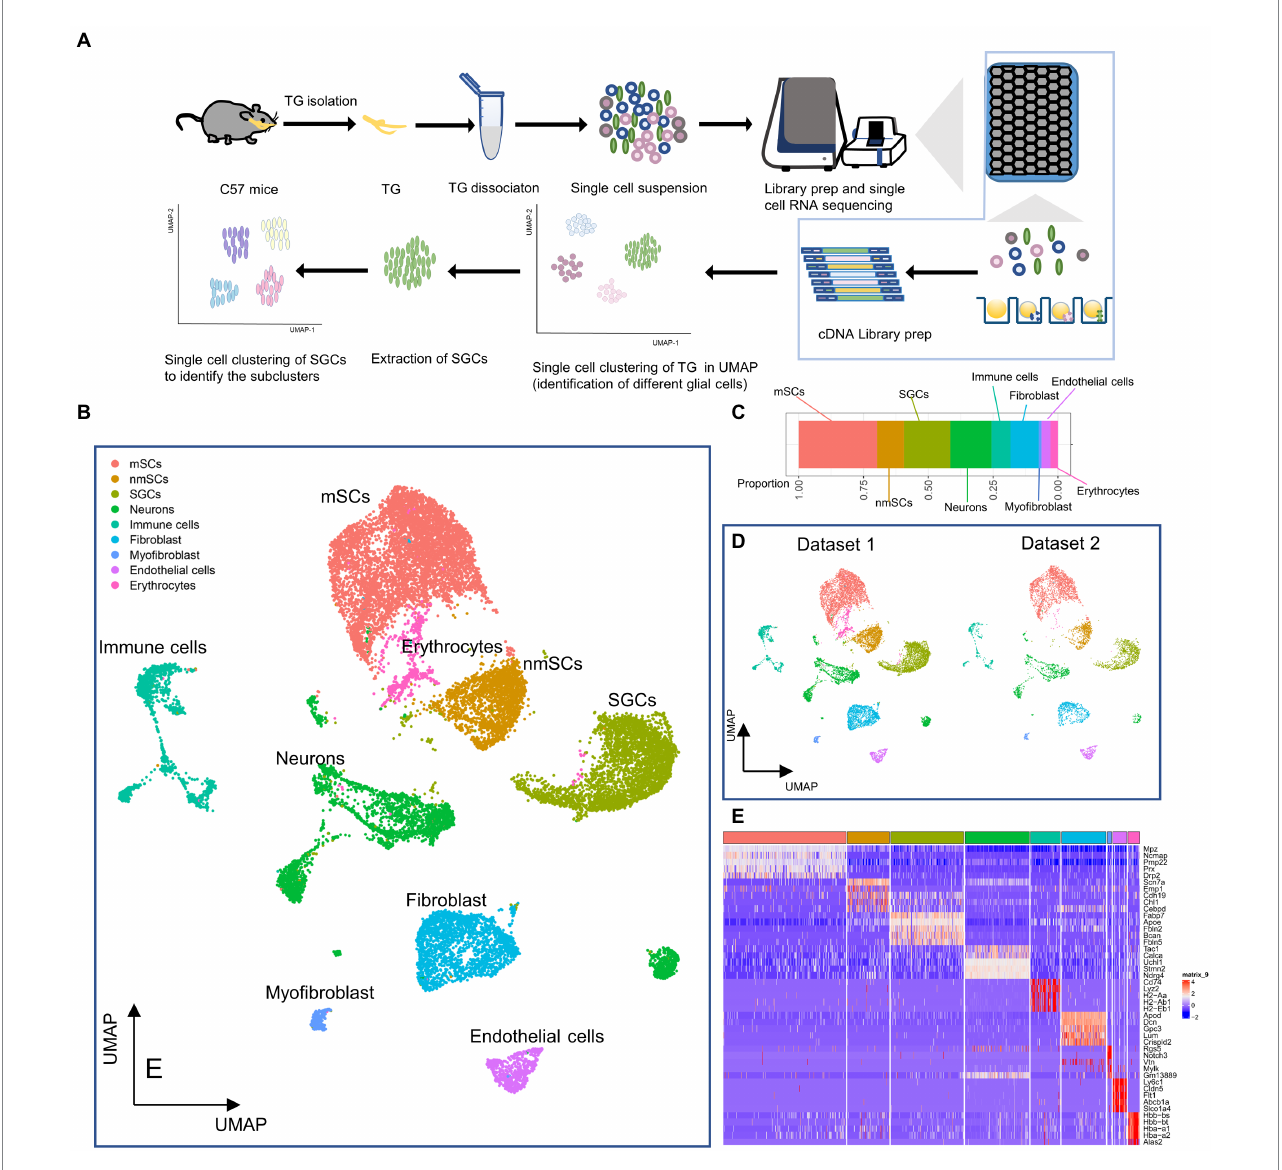
FIGURE 1 Identification of cell types in the profile of TG at the single cell level. (A) Scheme of experimental workflow for scRNA-seq and analysis of TG. (B) UMAP plot demonstrates clustering of TG. TG datasets 1 and 2 were combined, including neurons, SGCs (satellite glial cells), mSCs (myeloid Schwann cells), nmSCs (non-myeloid Schwann cells), immune cells, fibroblast, endothelial cells, myofibroblast, erythrocytes. Each dot represents one cell; Each color represents one cluster or one cell type. (C) The bar graph illustrates the proportion of cell types in TG. (D) The UMAP plots show the clustering of TG for dataset 1 and dataset 2, respectively. (E) The heat map of top5 genes for cell types of TG. The row is cell type, indicated by different colors. The column is top5 genes for each cell